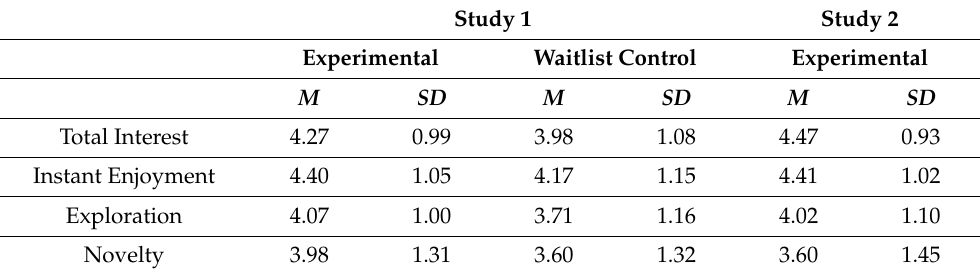
Table 2. Descriptive statistics for situational interest scores.